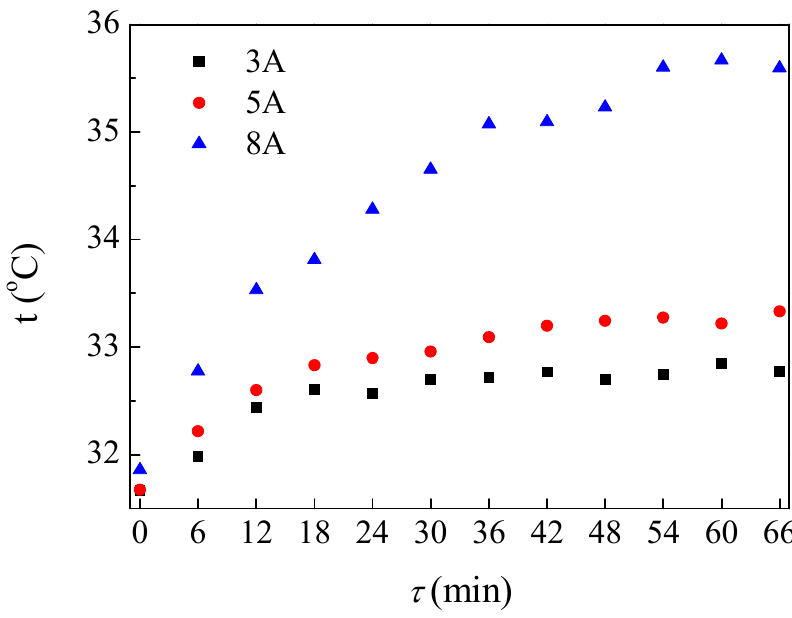
ff ect of current on temperature of lithium bromide regeneration Figure 7. Effect of current on temperature of lithium bromide regeneration solution. Figure 7. E